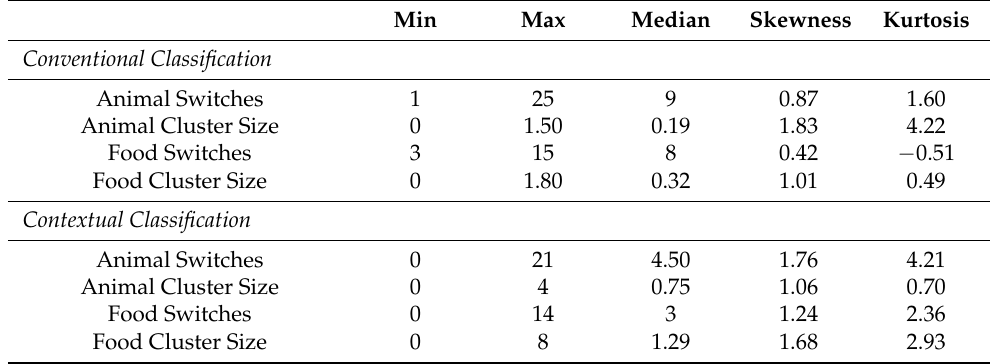
Table 2. Performance on verbal fluency tasks at Time 1; animal subtest n = 56 and food subtest n = 56.